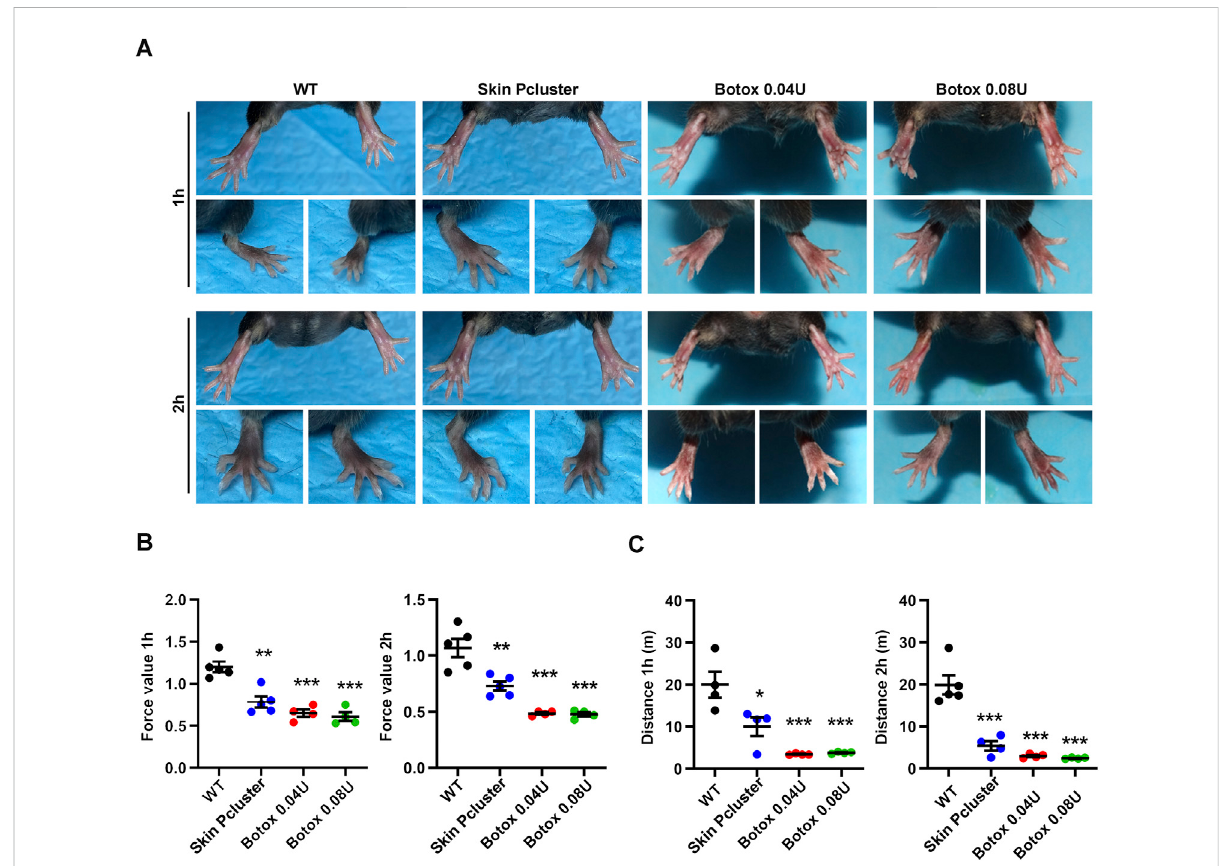
FIGURE 4 Study on paralytic relaxation of gastrocnemius in C57BL/6 mice. (A) The photographs of feet were recorded at 1h and 2 h after injection. (B , C) The effects of Skin Pcluster on gastrocnemius paralysis in mice were measured by force and drop distance with a digital force gauge. Statistic data were represented as mean ± sem (n = 4 or 5/group). P values were obtained by t